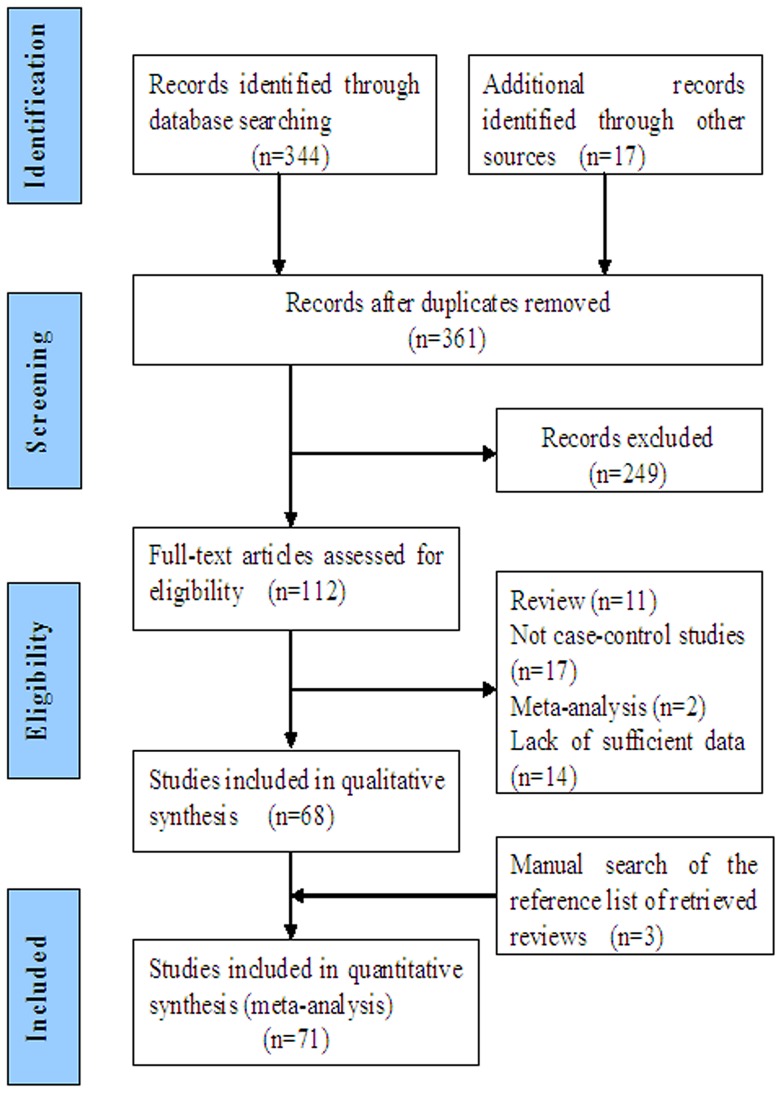
Flow diagram summarizing the search strategy.